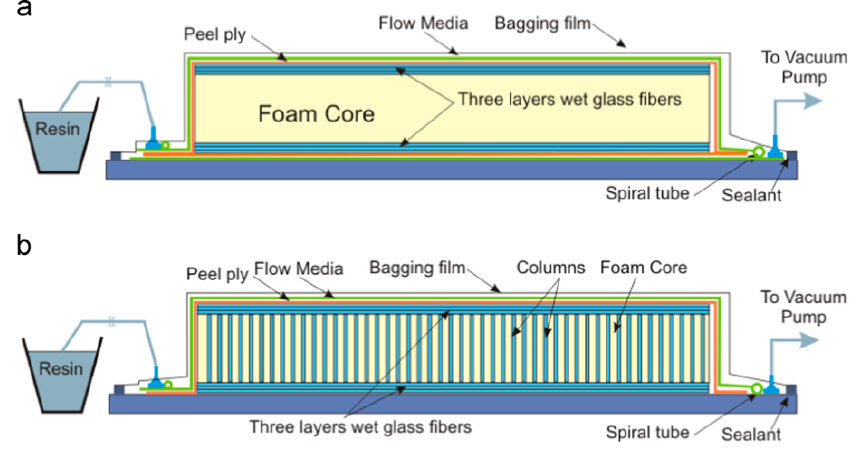
Figure 1. Schematic view of fabrication process of ( a ) (FCS) and ( b ) PFCS panels [3].